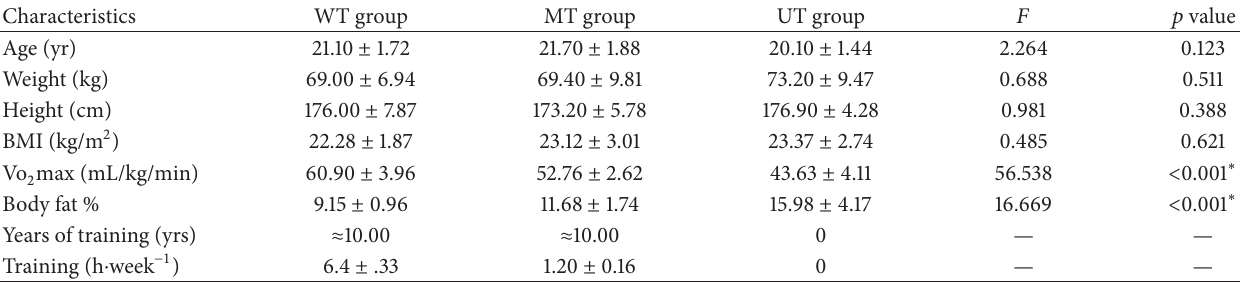
Table 1: Subjects’ characteristics of WT, MT, and UT